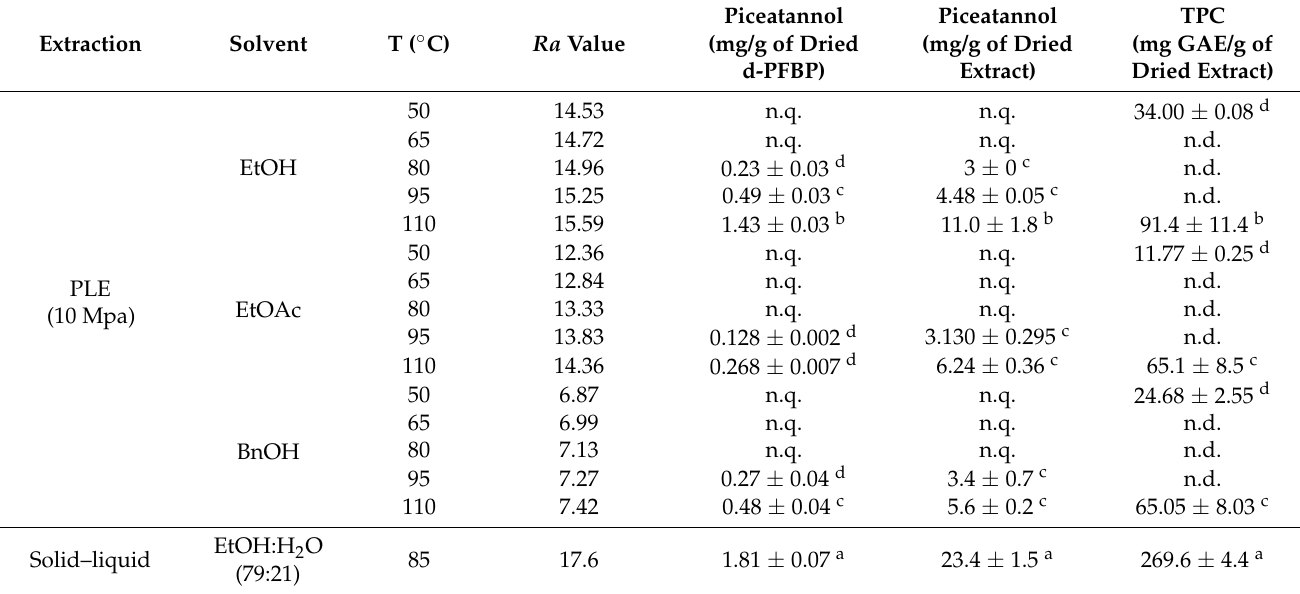
Table 2. Piceatannol content and TPC in d-PFBP extracts obtained by PLE using different solvents and conventional solid–liquid extraction.